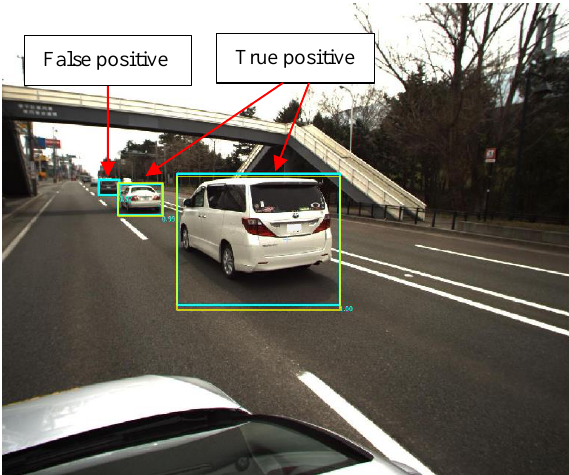
Figure 7. Results of VaS detection obtained using proposed model (cyan box: detection results, and yellow box: ground